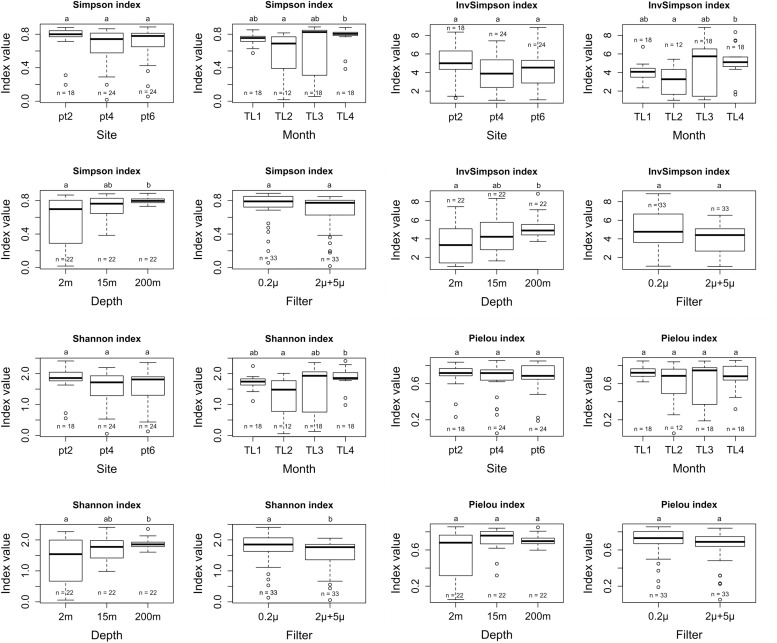
Simpson, InvSimpson, Shannon, and Pielou alpha diversity metrics for site, month, depth, and filter variables.